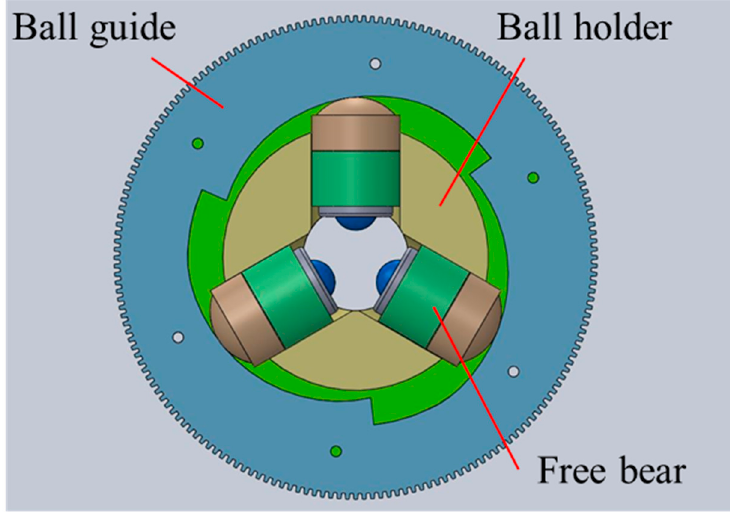
Figure 9. Schematic diagram of cam-implemented ball die.